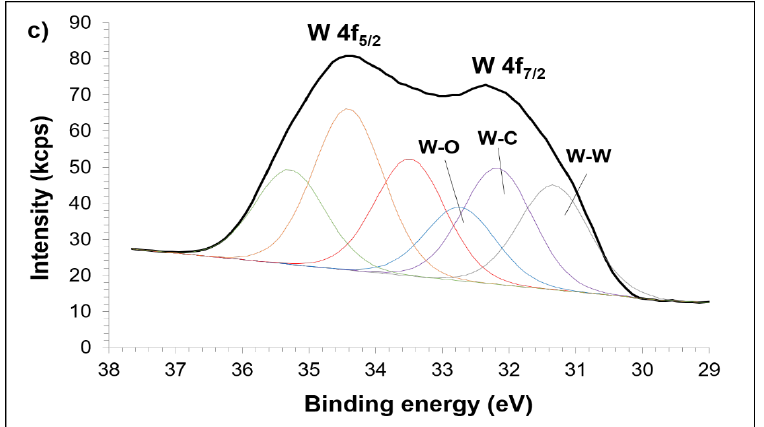
Figure 10. XPS curve fitting for ( a ) Cu 2p, ( b ) C 1s and ( c ) W 4f for sintered composite milled for 40 h. Figure 11 shows the SEM images of sintered composite at various milling times.